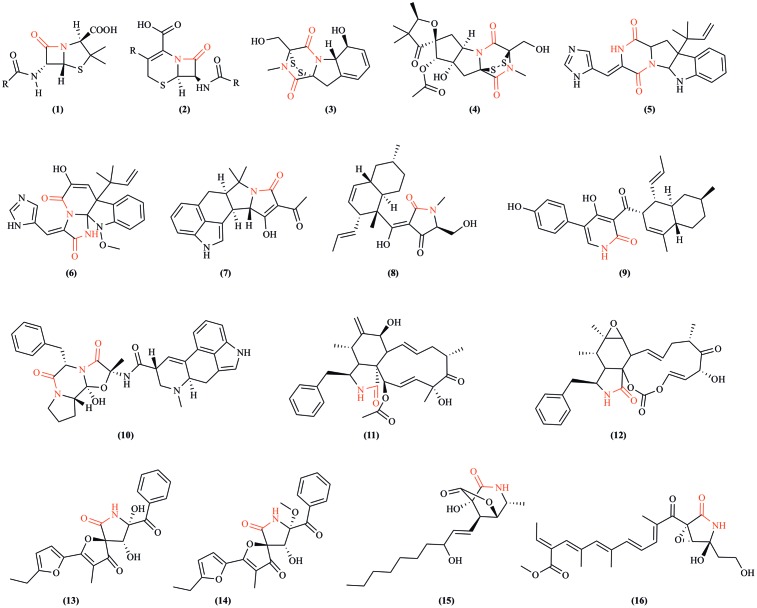
Examples of lactam-containing fungal compounds. Lactam bonds are highlighted in red. (1) Penicillin, the historically significant fungal lactam produced by Penicillium chrysogenum (Fleming, 1929); (2) cephalosporins, a group of bactericidal β-lactams from Acremonium chrysogenum (Harrison and Bratcher, 2008); (3) gliotoxin, a mycotoxin produced by Aspergillus fumigatus and several other species (Forseth et al., 2011); (4) sirodesmin PL, a phytotoxin produced by the fungus Leptosphaeria maculans causing blackleg disease of canola (Gardiner et al., 2004); (5) roquefortine C, a mycotoxin produced by Penicillium species (Kokkonen et al., 2005); (6) meleagrin, a bioactive alkaloid produced by deep ocean Penicillium (Nozawa and Nakajima, 1979); (7) cyclopiazonic acid, a toxic fungal secondary metabolite originally isolated from Penicillium cyclopium (Holzapfel, 1968); (8) equisetin, a Fusarium equiseti metabolite (Hazuda et al., 1999); (9) ilicicolin H is an NRPS-polyketide hybrid product discovered from Cylindrocladium iliciola MFC-870 and is a potent antifungal agent (Singh et al., 2011); (10) ergotamine, an ergopeptine and part of the ergot family of alkaloids from Claviceps purpurea (Schiff, 2006); (11) cytochalasin D, a cytostatically active metabolite isolated from Tubercularia species (Wang et al., 2003); (12) cytochalasin E from Rhinocladiella species (Wagenaar et al., 2000); (13) azaspirofuran A and (14) azaspirofuran B produced by Aspergillus sydowii (Ren et al., 2010); (15) awajanomycin produced by Acremonium species (Jang et al., 2006); (16) fusarin C, a mycotoxin produced by several Fusarium species (Wiebe and Bjeldanes, 1981).